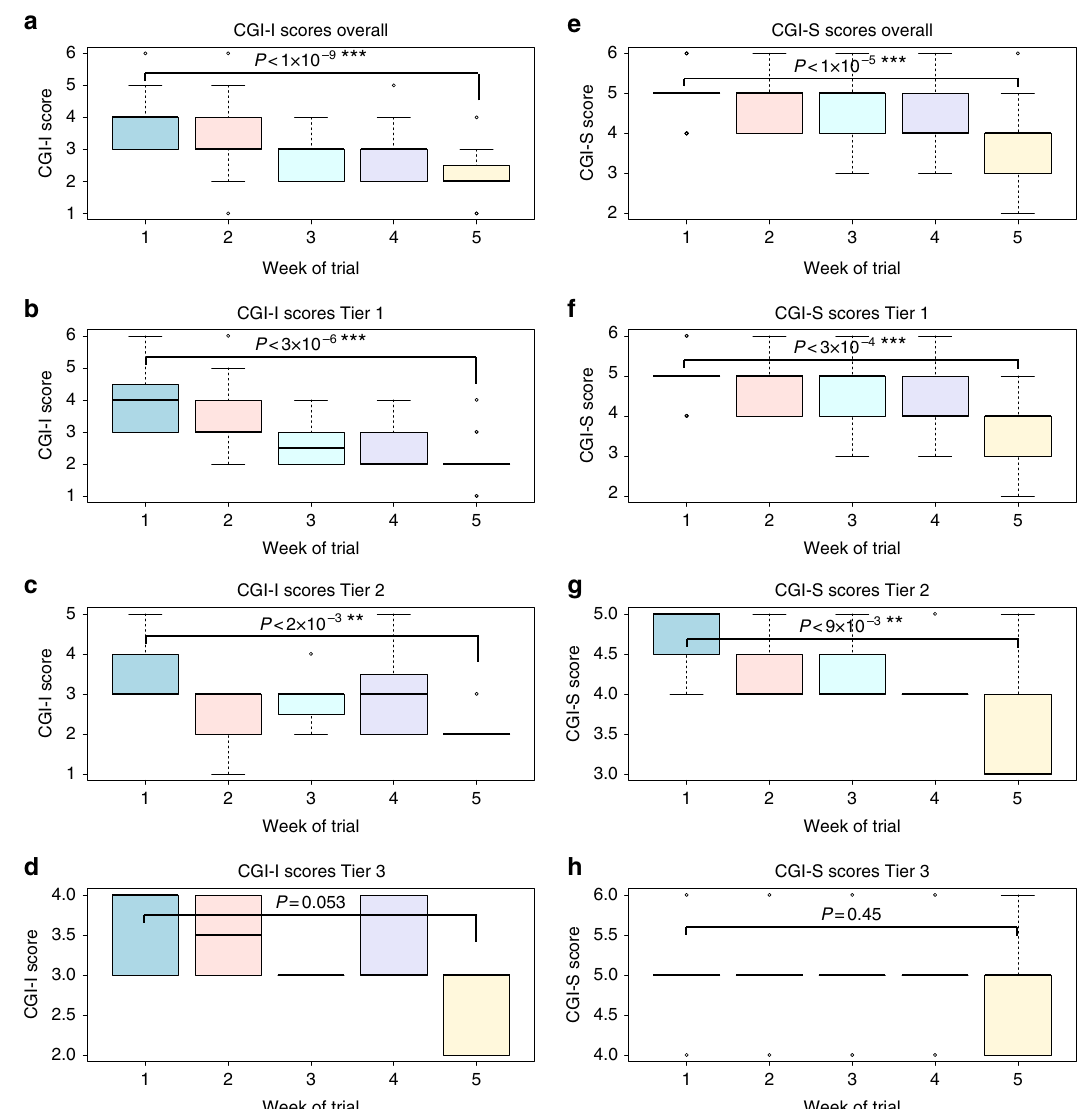
Fig. 1 Week by week box-and-whisker plots showing the results for the CGI-I ( a – d ) and CGI-S ( e – h ) scaled inventories for all study subjects ( a , e ) or strati fi ed by genetic tiers (Tier 1 ( b , f ), Tier 2 ( c , g ), and Tier 3 ( d , h )). P -values denote results of the paired Student ’ s t -test between results from study baseline (week 1) and fi nal (week 5). N = 30. The edges of the box plots denote 25 and 75% tiles, while the solid black horizontal line denotes the cohort median. Upper and lower whiskers denote the limits of the nominal range of the data inferred from the upper and lower quartiles (Methods section) and plotted points are outliers from these